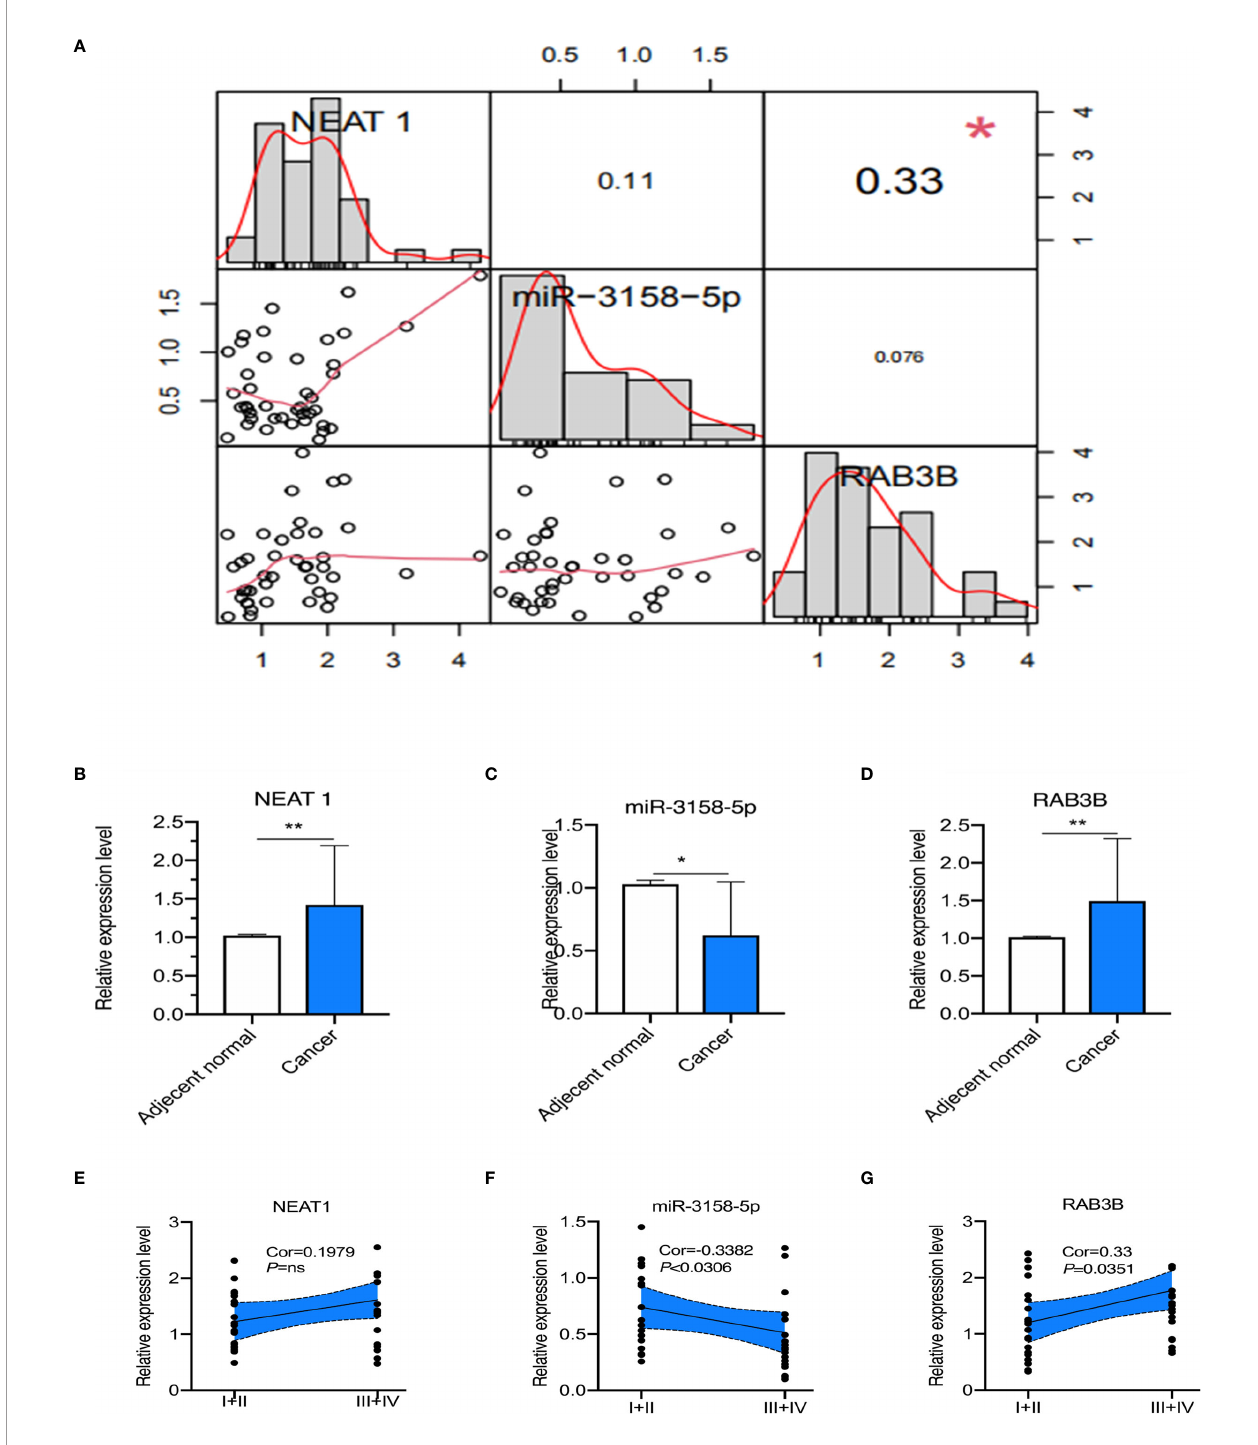
FIGURE 9 | The correlation and prognosis effect among lncRNA NEAT1, miR-3158-5p, and RAB3B expression in gastric cancer (GC) patients. (A) The correlation among lncRNA NEAT1, miR-3158-5p, and RAB3B. (B) The expression of lncRNA NEAT1 in GC and adjacent normal tissues. (C) The expression of miR-3158-5p in GC and adjacent normal tissues. (D) The expression of RAB3B in GC and adjacent normal tissues. (E) The expression of lncRNA NEAT1 in GC patients of different stages. (F) The expression of miR-3158-5p in GC patients of different stages. (G) The expression of RAB3B in GC patients of different stages. For Panels (A – D) , n = 41, * p < 0.05, ** p < 0.01; for panels (E – G) , n = 20 –